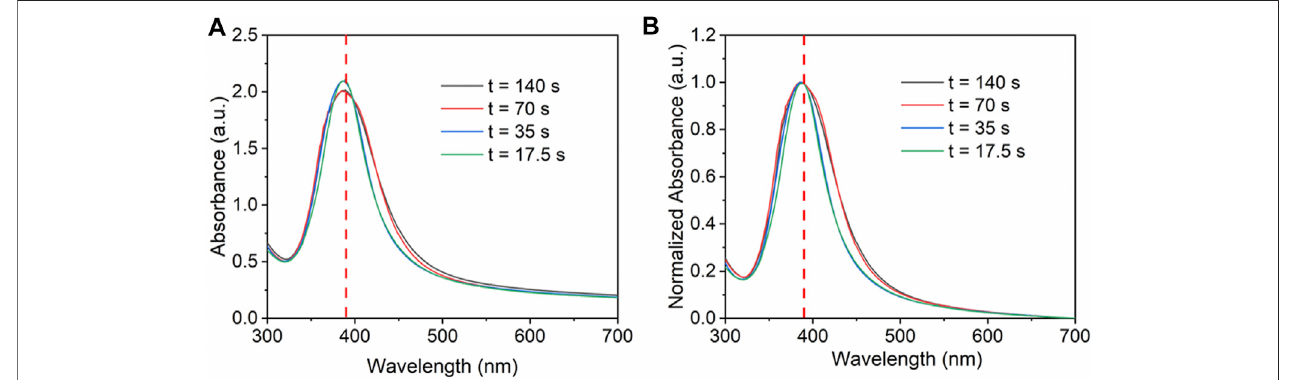
FIGURE 4 | (A) UV-vis absorbance spectra and (B) normalized absorbance spectra for Ag/SBA-15 synthesized at different fl ow